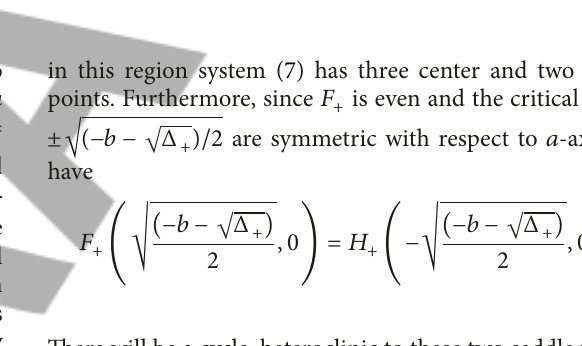
Figure 1: Bifurcation sets and phase portraits of (8) with 𝛾 = 1 in different parametric